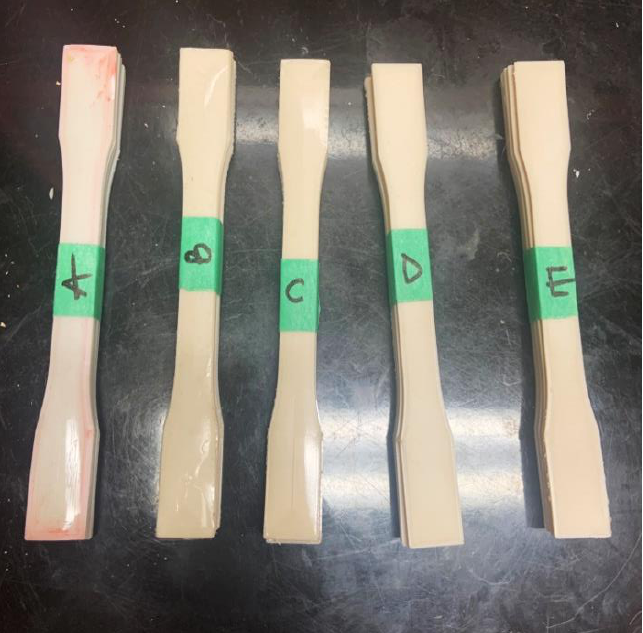
Figure 2. Typical 3D printed tensile test specimens: ( A ) Pure PHB/PLA with 0 wt.% corncob; ( B ) 2 wt.% corncob; ( C ) 4 wt.% corncob; ( D ) 6 wt.% corncob; and ( E ) 8 wt.%